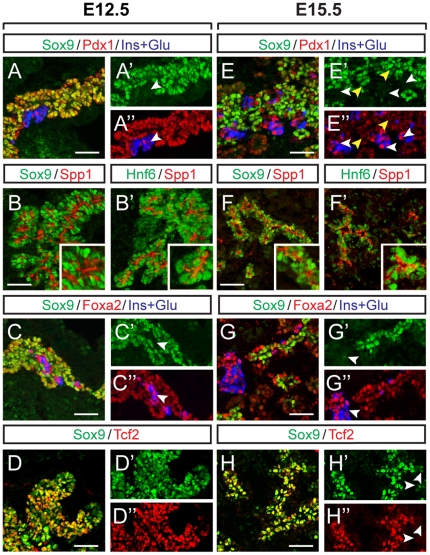
Sox9 is co-expressed with Hnf6, Foxa2, Tcf2, and Pdx1 in progenitor cords of the developing pancreas.Immunofluorescence staining of e12.5 (A–D) and e15.5 (E–H) wild-type pancreata reveals extensive overlap of the Sox9+ domain with Hnf6 (B, F), Foxa2 (C, G), and Tcf2 (D, H). (B, F) Osteopontin (Spp1), which marks the apical surface of cells in the lumen of the epithelial cords, is used as a reference for the Sox9 and Hnf6 expression domains. (A) Sox9 is widely coexpressed with Pdx1 throughout the pancreatic epithelium at e12.5. Pdx1+/Sox9− cells at this stage are insulin/glucagon+ (ins+glu) (A′-A″, white arrowheads). (E) At e15.5, Sox9+ cells are found restricted to the inner epithelial layer and are weakly Pdx1+ (E′-E″, yellow arrowheads). At this time, differentiated cells expressing high levels of Pdx1 are insulin/glucagon+, but Sox9− (E′-E″, white arrowheads). Similarly, Foxa2+/Sox9− cells producing insulin/glucagon are present at e12.5 (C′-C″, white arrowheads), as well as at e15.5 (G′-G″, white arrowheads). (D) At e12.5, Sox9 and Tcf2 widely colocalize throughout the pancreatic epithelium. (H) By e15.5, some cells that are Sox9+/Tcf2− are visible at the distal tips of the epithelial cords (H′-H″, white arrowheads). Scale bars: 50 µm.